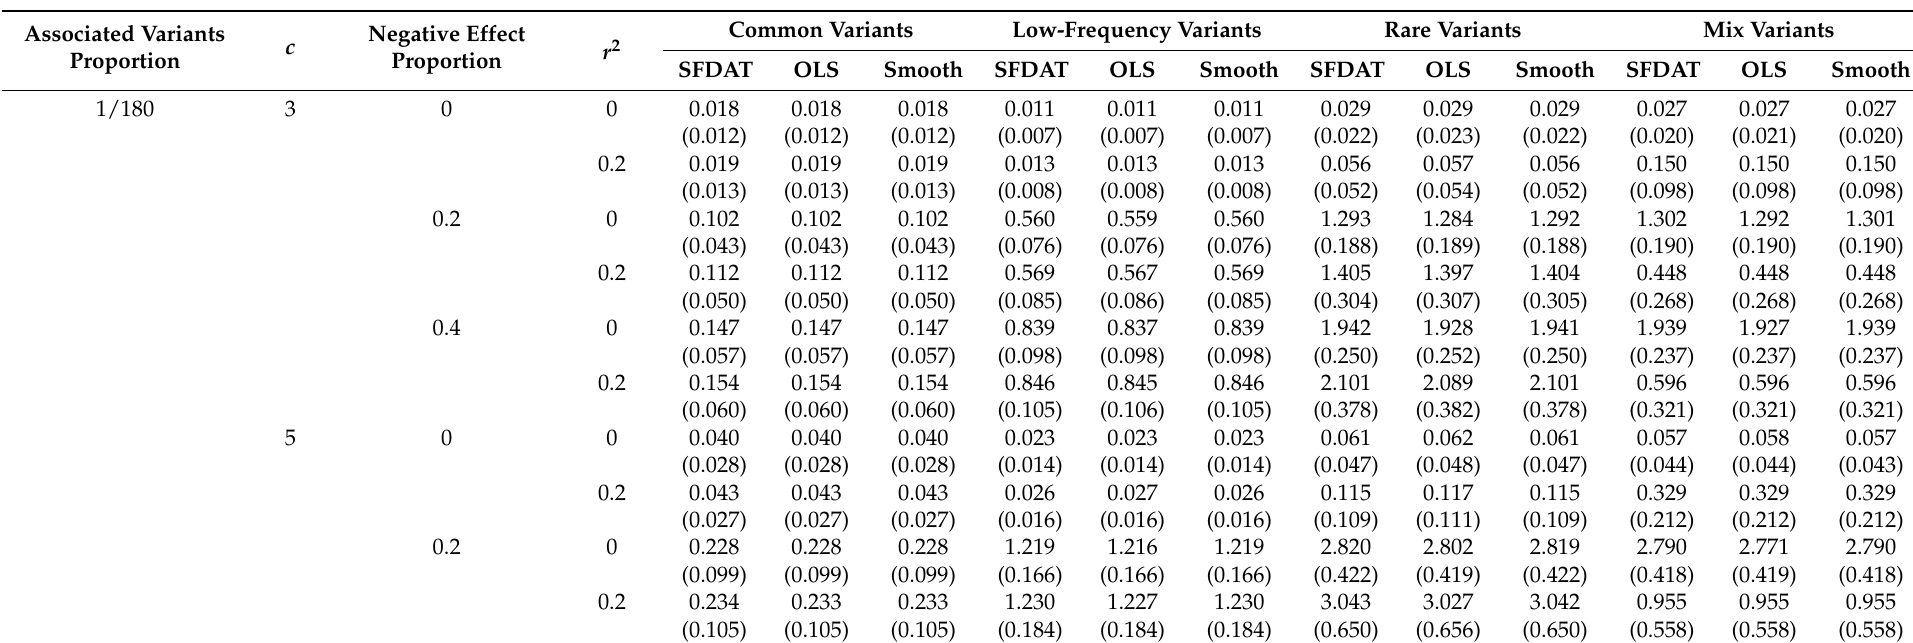
Table 3. The means and standard errors (in the parenthesis) of ISE 1 for association analysis of simulated quantitative trait based on SFDAT, OLS and Smooth on linkage equilibrium and linkage